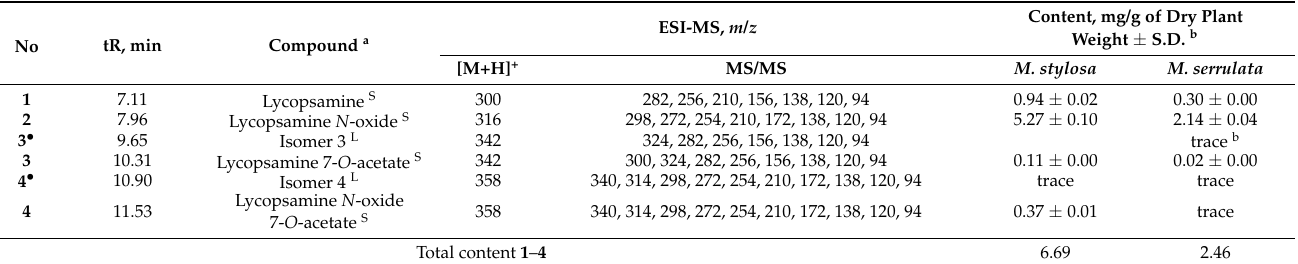
Table 2. Chromatographic (t R ), mass-spectrometric data (ESI-MS), and content of pyrrolizidine alkaloids in Mertensia stylosa и M. serrulata herb